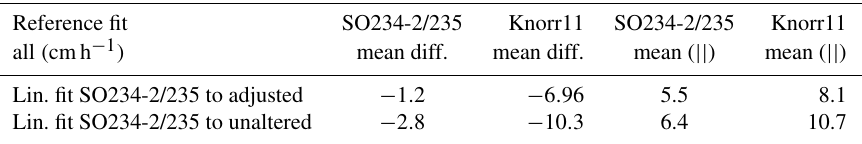
Figure 3. Adjustments to the Knorr11 DMS k vs. u relationship. The datapoints with | Re tr | ≺ 6 . 96 × 10 5 were adjusted using the gas transfer suppression model. Black circles denote k values at the original wind speed u 10 . Colored filled circles denote the k value at wind speed equal to u alt . The color shows the significant wave height. If a datapoint has a concentric black and filled circle, it was not adjusted, as it was not subject to gas transfer suppression. The solid black line is the ZA18 parameterization. The dotted line is the linear fit to the datapoints before the adjustment; the dashed line is the linear fit after the adjustment. Table 1. Mean differences between the reference fits (column one) and the adjusted and unadjusted k data sets. A negative value describes that the fit, on average, overestimates the actual measured data. The mean of the absolute value is presented in the last two columns.